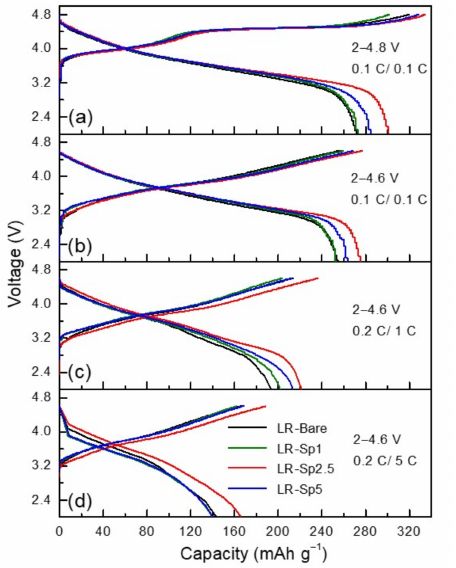
Figure 7. Charge and discharge performance at ( a ) 0.1 C/0.1 C between 2–4.8 V, ( b ) 0.1 C/0.1 C, ( c ) 0.2 C/1 C and ( d ) 0.2 C/5 C between 2–4.6 V for the LR–Bare, LR–Sp1, LR–Sp2.5, and LR–Sp5